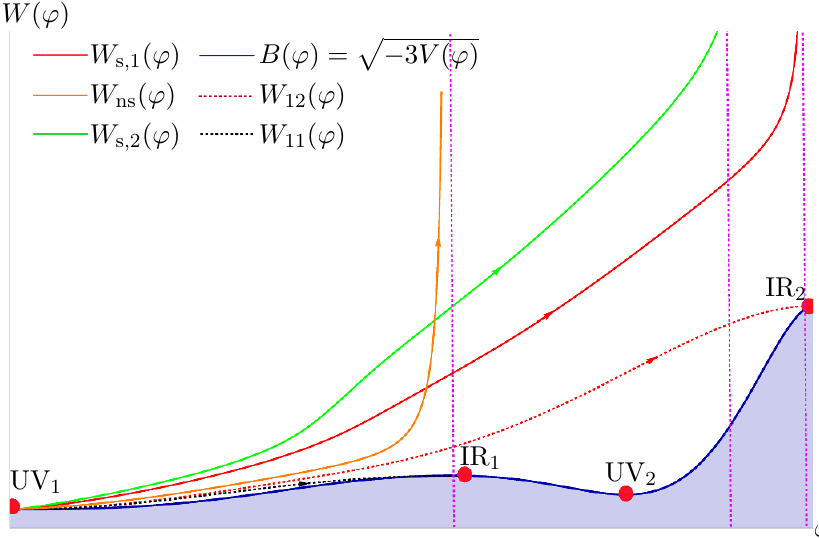
Figure 25. The solid lines represent the superpotential W ( ’ ) corresponding to the three di(cid:11)erent solutions starting from UV 1 which exist at small positive curvature. Two of them (red and green curves) are skipping (cid:13)ows and the third one (orange curve) is non-skipping. For comparison, we also show the (cid:13)at RG (cid:13)ows (dashed